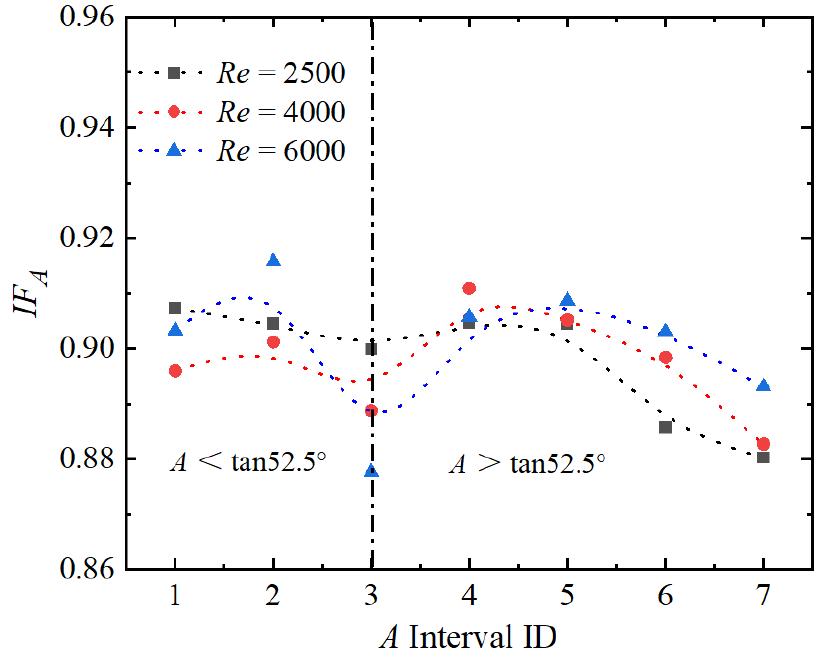
Figure 30. The impact factor of A on Nu ave ( Re in = 2500~6000, q = 1 kW/m 2 , and 29% Xe).